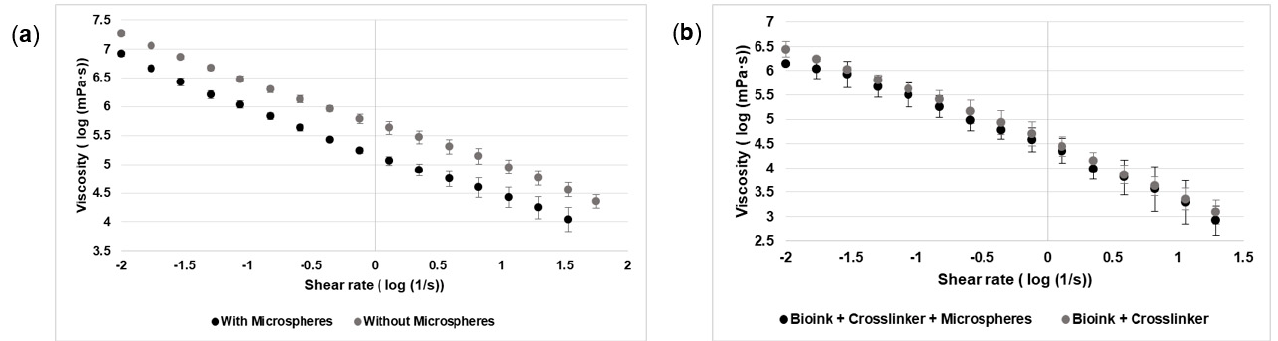
Processes 2021 , 9 , x FOR PEER REVIEW Figure 8. Rheological properties. ( a ) Viscosity/shear rate curve of bioprinted constructs with and without microspheres. ( b ) Viscosity/shear rate curve of manually combined bioink and crosslinker printed constructs with and without microspheres.